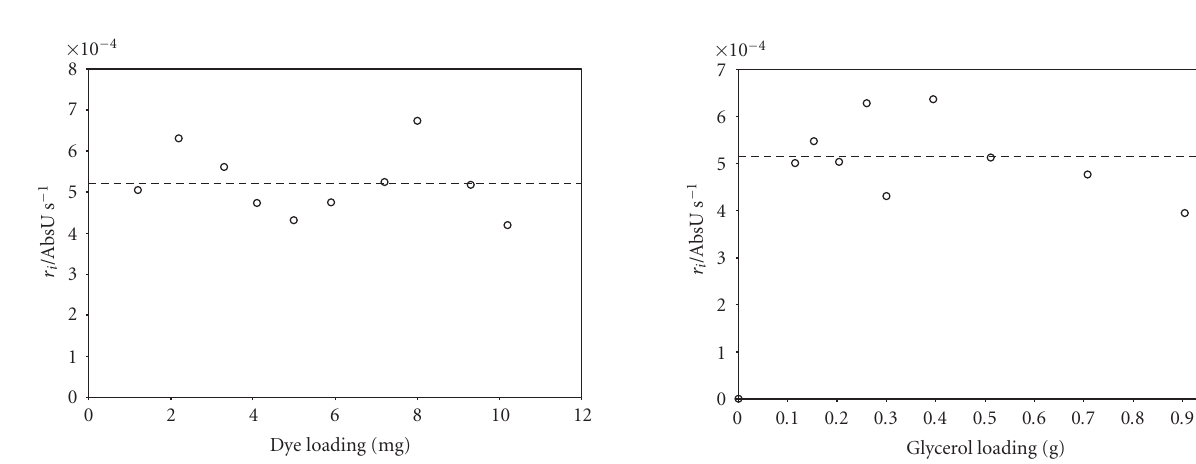
Figure 4: The variation in r i as the level of glycerol in the ink formulation is altered between 0.1 and 0.9 g. As in Figure 3, the dotted line in the plot indicates the average r i of 5.15 × 10 − 4 AbsU s − 1